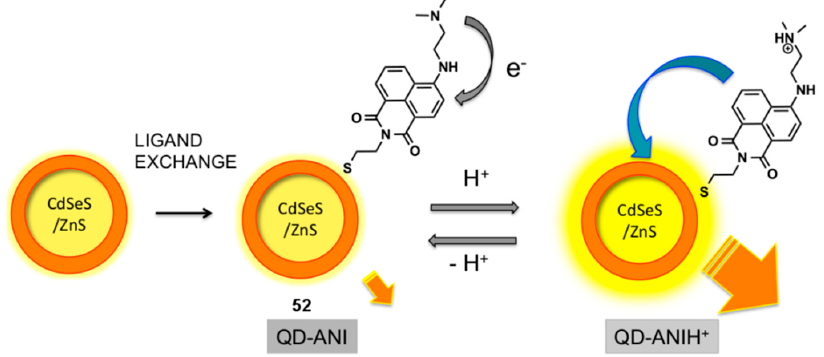
Figure 22. Quantum dot (QD)/aminonaphthalimide (ANI) conjugate that functions as a